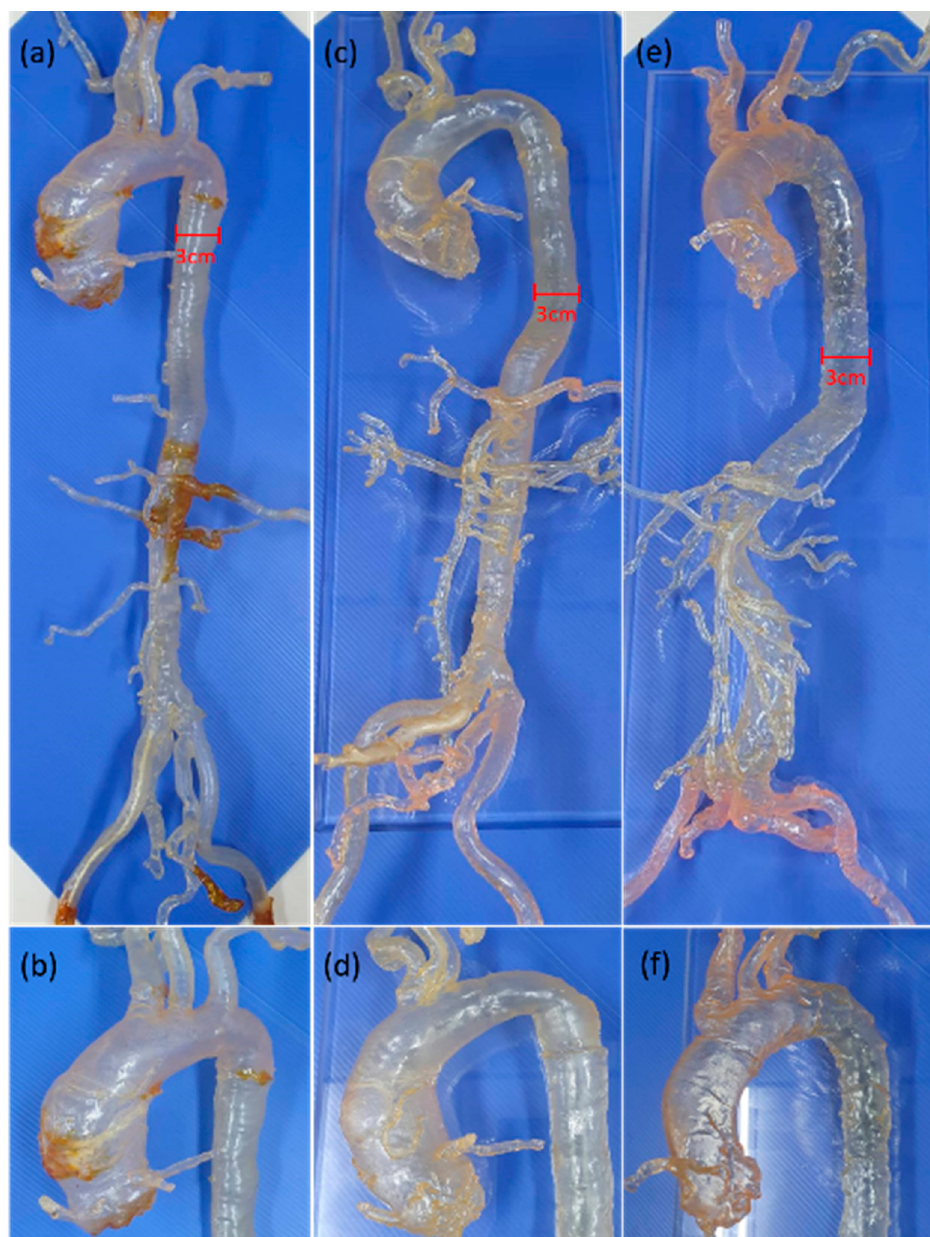
Figure 2. Whole picture of full-sized carotid-aortic-iliac vascular simulators and a magnified view of the aortic arch. ( a , b ) Type I arch; ( c , d ) bovine variant; ( e , f ) type III